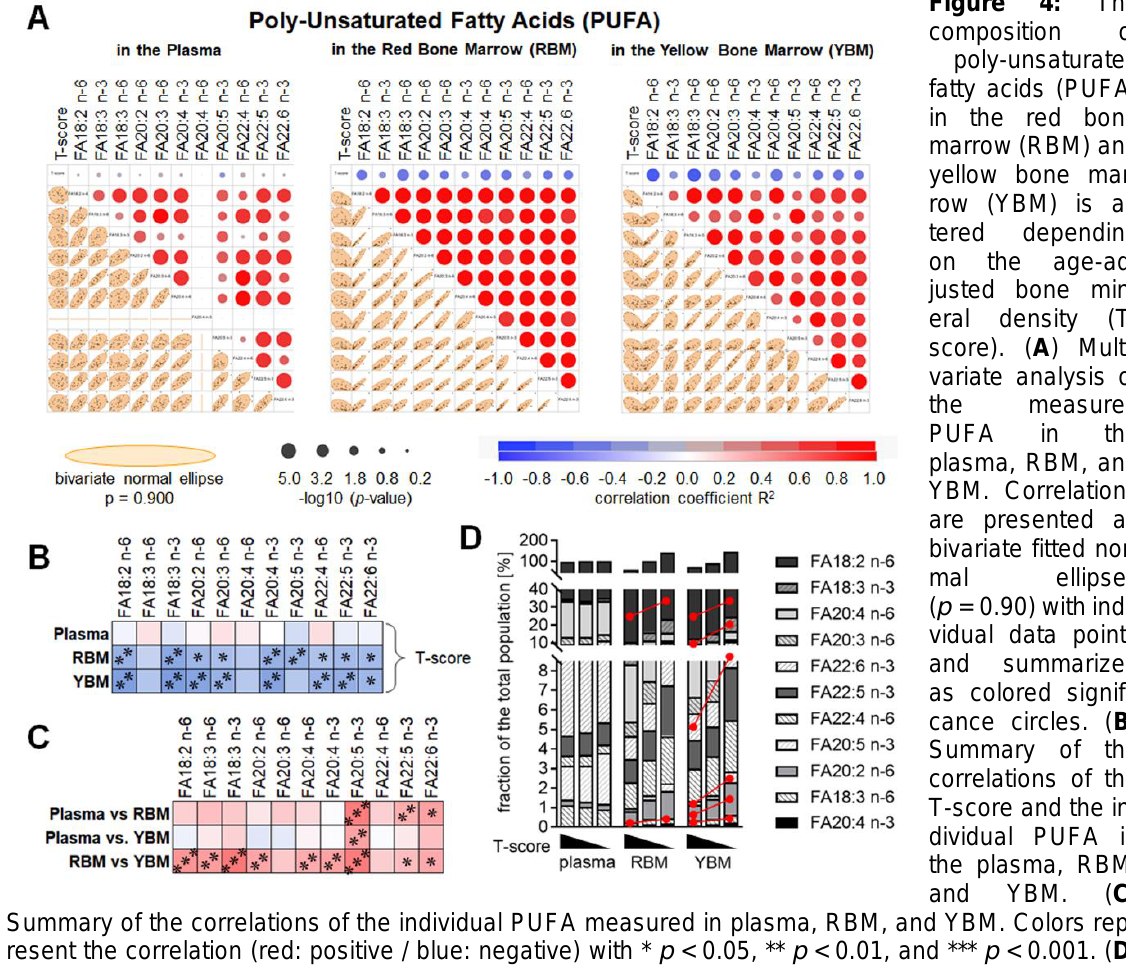
Figure 4: The composition of poly-unsaturated fatty acids (PUFA) in the red bone marrow (RBM) and yellow bone mar- row (YBM) is al- tered depending on the age-ad- justed bone min- eral density (T- score). ( A ) Multi- variate analysis of the measured PUFA in the plasma, RBM, and YBM. Correlations are presented as bivariate fitted nor- mal ellipses ( p = 0.90) with indi- vidual data points and as colored signifi- cance circles. ( B ) Summary of the correlations of the T-score and the in- dividual PUFA in the plasma, RBM,